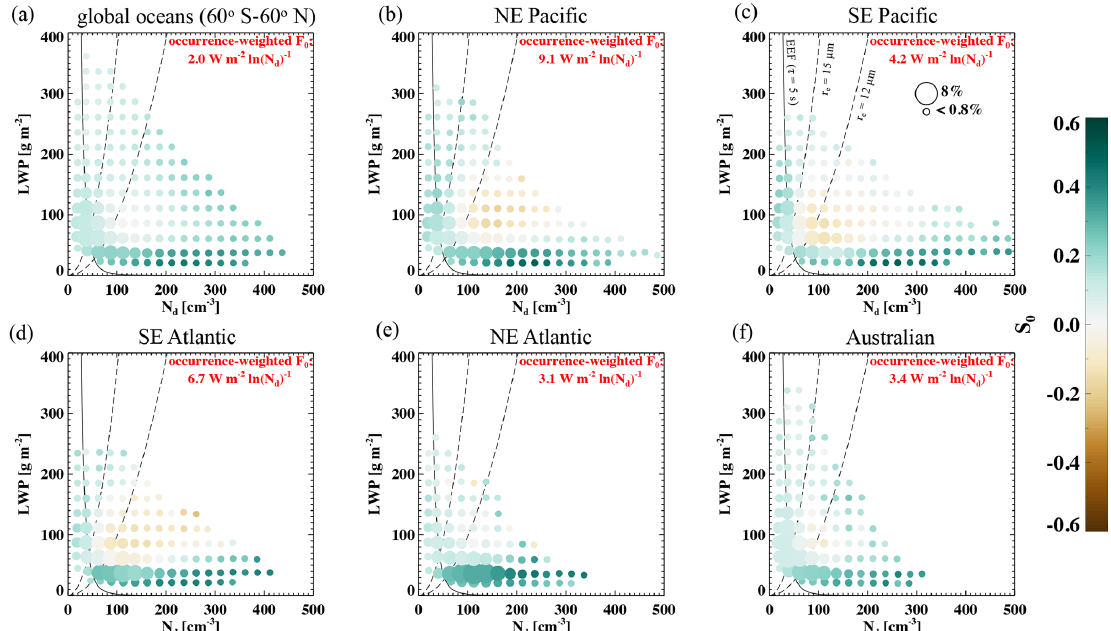
Figure 2. Cloud albedo susceptibility ( S 0 , colored filled circles) in LWP– N d variable space, as bin means (bin size of 25gm − 2 and 25cm − 3 ), for (a) global oceans (60 ◦ S–60 ◦ N) and 20 ◦ × 20 ◦ boxes over (b) NE Pacific, (c) SE Pacific, (d) SE Atlantic, (e) NE Atlantic, and (f) Aus- tralian stratocumulus regions. The size of the circles indicates the frequency of occurrence of an LWP– N d bin (reference circle sizes with corresponding occurrence are indicated in panel c ). Bins with less than 0.01% frequency of occurrence (or fewer than 25 samples) are not shown. Isolines of evaporation–entrainment feedback (EEF; phase relaxation timescale of 5s) and isolines of r e of 12 and 15µm based on an adiabatic condensation rate of 2.14 × 10 6 kgm − 4 (dashed black; commonly used measures of precipitation) are indicated in panel (c) . Mean radiative susceptibility ( F 0 ) weighted by the frequency of occurrence of each LWP– N d bin and the effective cloud frequency (freq eff , defined in Eq. 1) is printed in red (named occurrence-weighted F 0